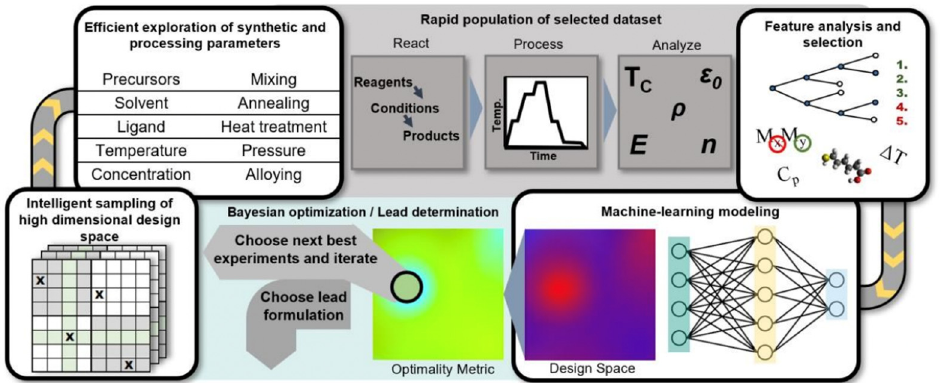
Figure 9. Schematic depiction of an example of a machine-learning workflow for the iterative explo- ration and exploitation of a synthetic design space for inorganic materials, reprinted with the per- mission from [78].